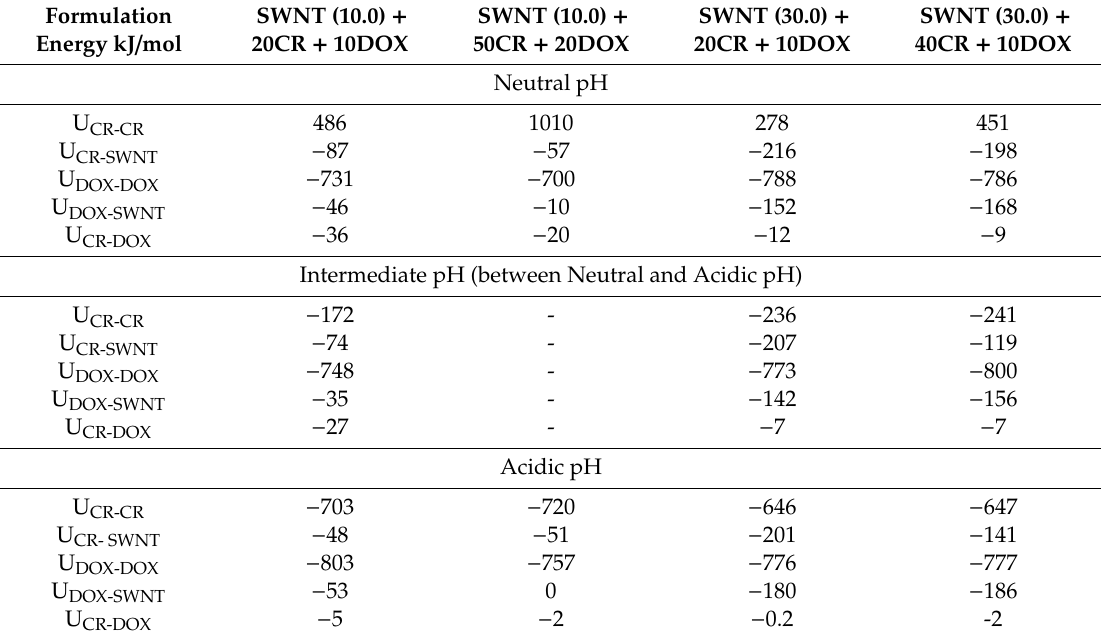
Figure 8. The structure of SWNT-CR-DOX systems at neutral pH ( a ) and acidic pH ( b ). The system contains narrow carbon nanotubes (10.0), 50 CR molecules (red) and 20 DOX molecules (blue). Ionic strength of the solutions is 0.264 M. Arrows show ribbon-like CR structure. Inset: scanning electron microscope photograph of nanotube (10 nm wide) with CR-DOX complex bound to the surface (higher concentration of CR = 5 mg / mL) at neutral pH. Table 1. The average energies of interaction between di ff erent components of the SWNT-CR-DOX system. Energies are expressed in kJ mol − 1 and were calculated for pairs of molecules. Formulation SWNT (10.0) + SWNT (10.0) Energy kJ / mol 20CR + 10DOX